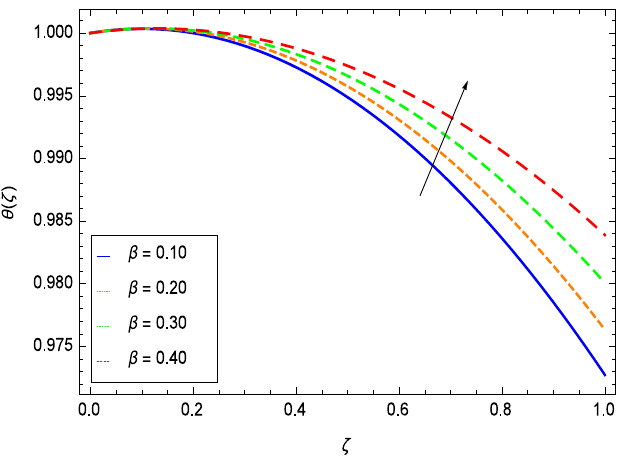
Figure 12. Conduction layer at h = − 3.00, φ = 0.40, n = 1.50, We = 0.50, S = 0.50, M = 2.00, Nr = 1.00, Pr = 10.00, A 3 = A 4 = 0.20, A = π with the enhancement in β . 4